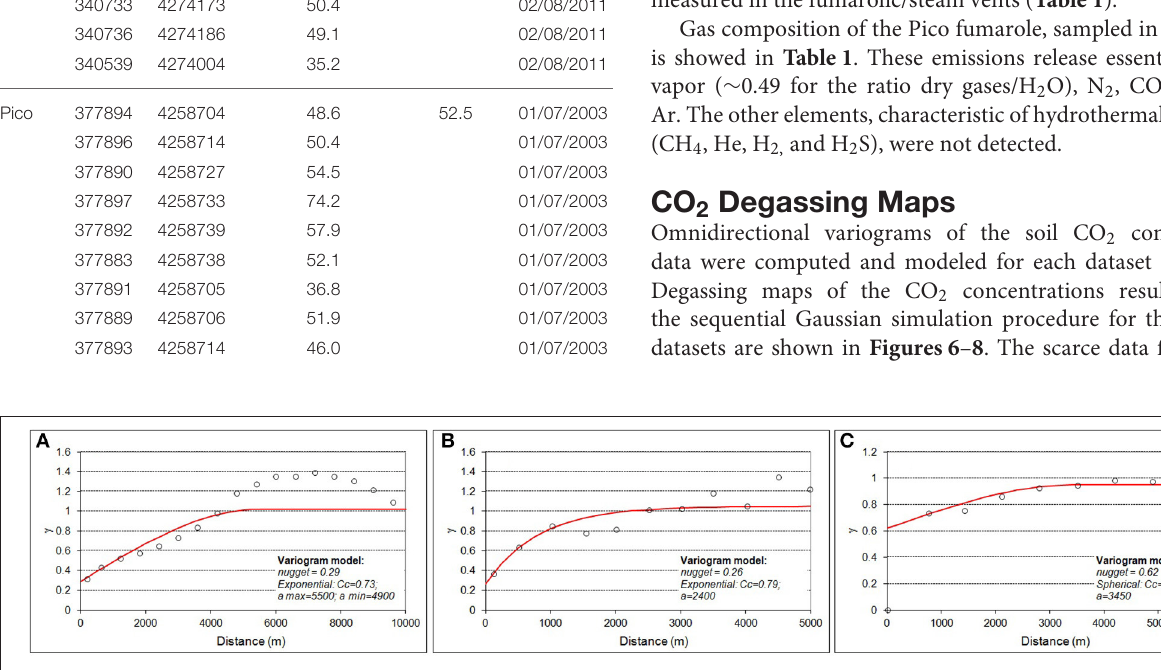
FIGURE 5 | Omnidirectional variograms of the soil CO 2 concentration data for Faial (A) , Pico (B) , and São Jorge (C) . Cc: Partial sill; a: range (in m).